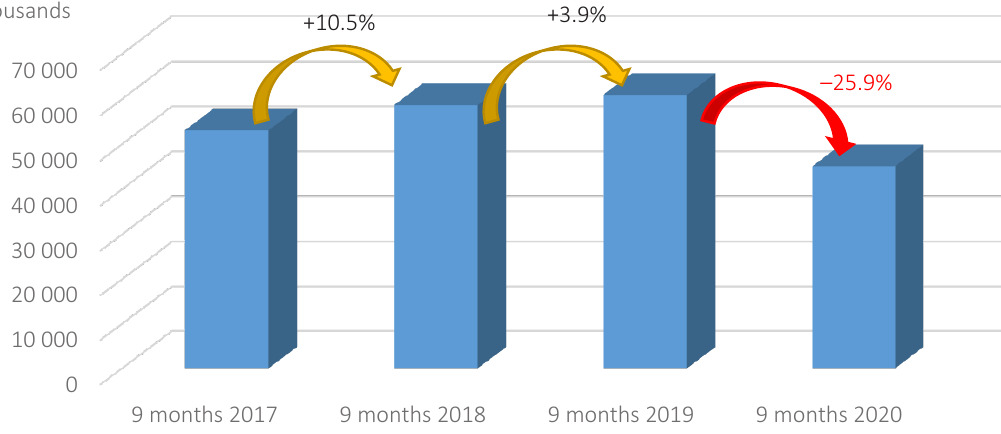
Figure 4. Dynamics of insurance policies number for 9 months